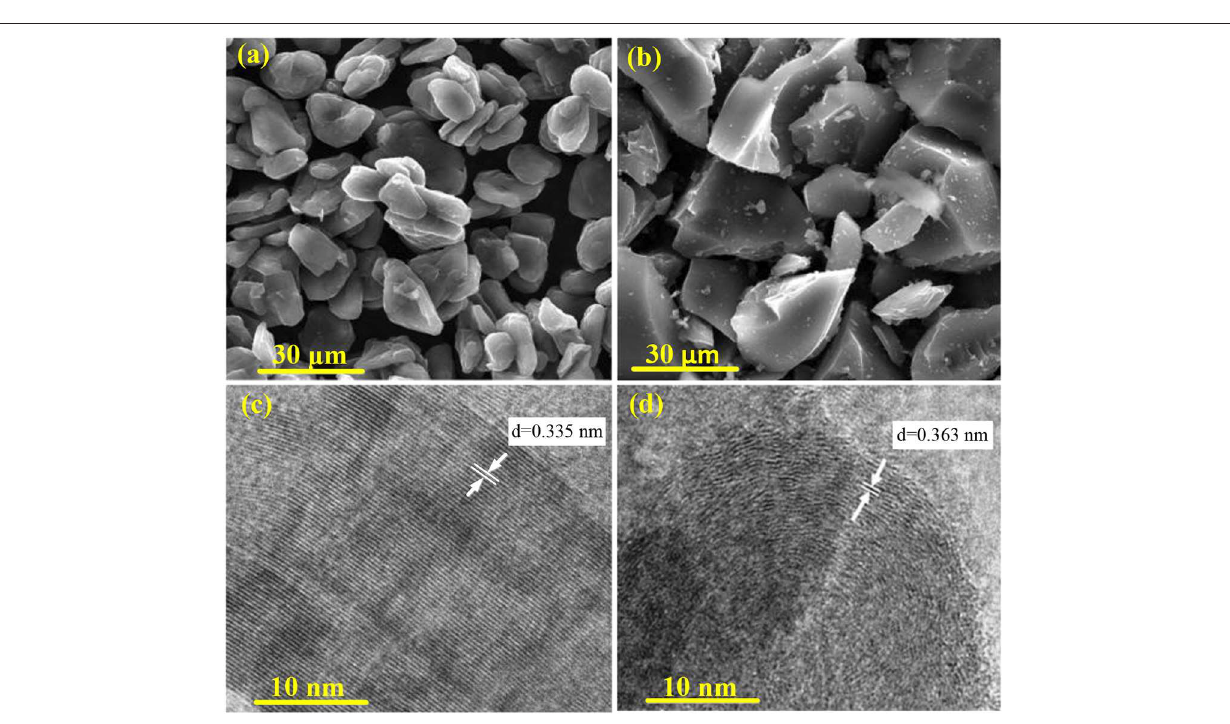
FIGURE 2 | (a) SEM images of graphite sample; (b) SEM images of PAN hard carbon; (c) TEM images of graphite sample; (d) TEM images of PAN hard